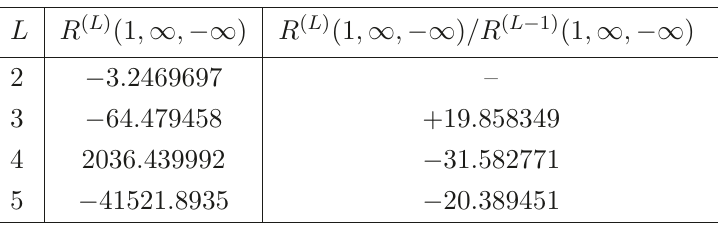
Table 8. The value of the remainder function at ( u, v, w ) = (1 , ∞ , −∞ ) , i.e. the v → + ∞ limit of the u = 1 line, at loop order L , as well as the ratio to the previous loop order. The five-loop to four-loop ratio is not quite as close to the cusp asymptotic value of − 16 as was the case at ( u, v, w ) = (1 , 1 , − 1)